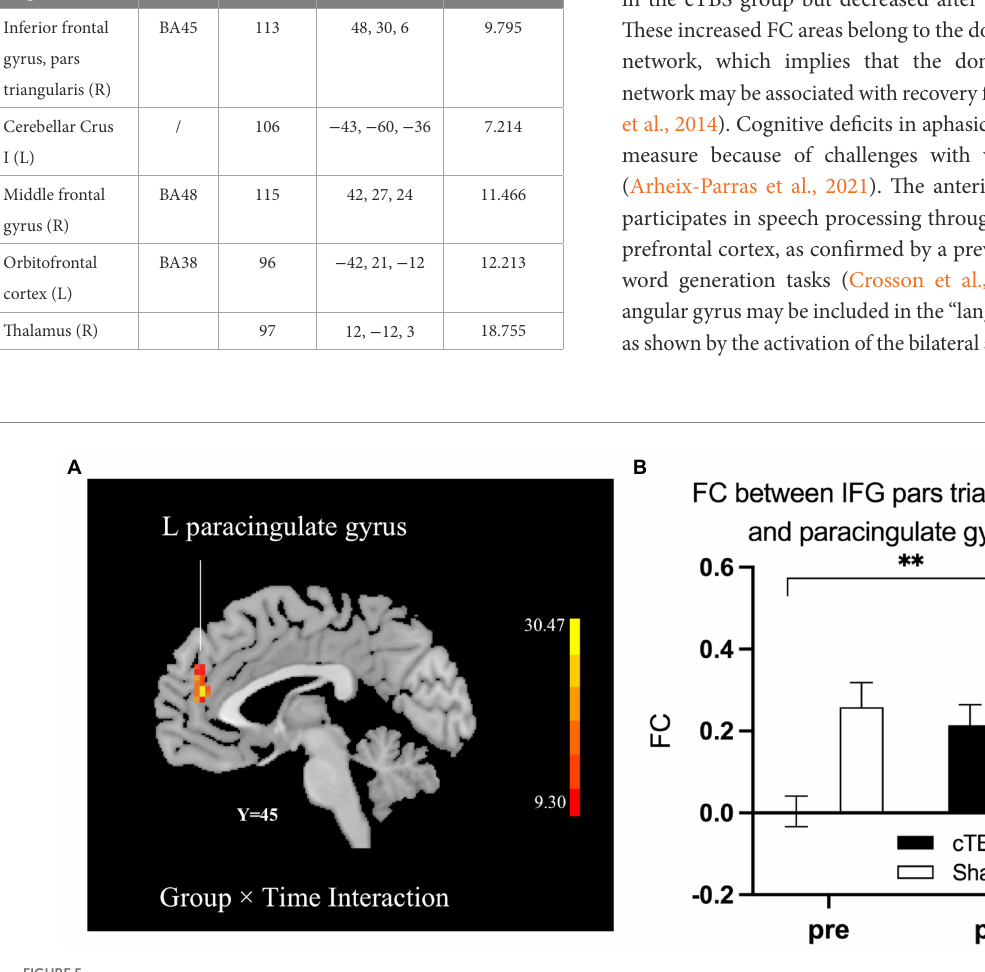
FIGURE 5 cTBS-induced changes in intrinsic functional connectivity (FC) between the right pars triangularis and the left paracingulate gyrus (A) . The cTBS group demonstrated increased FC between the right pars triangularis and left paracingulate gyrus after treatment, but FC between these regions was reduced after treatment in the sham group. Bars show means, and error bars represent the standard error of the mean (SEM). We used a 2-factor mixed-effects ANOVA. ** indicates p < 0.001 in (B)